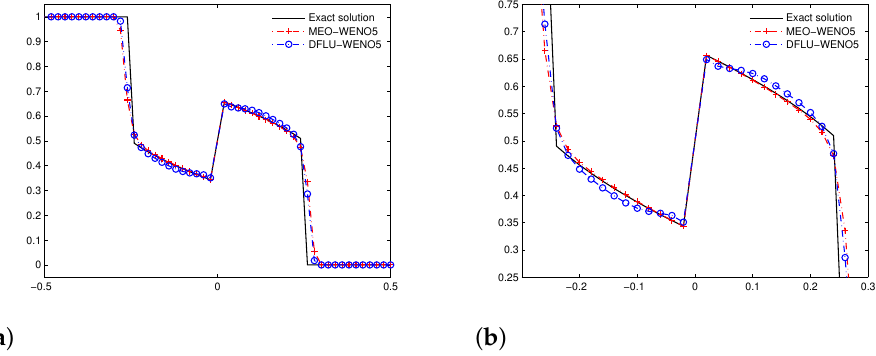
Figure 9. Example 2 computed by the MEO-WENO5 and DFLU-WENO5 with ∆ x = 1/50. ( a ): the numerical and exact solutions; ( b ): the numerical and exact solutions zoomed in.